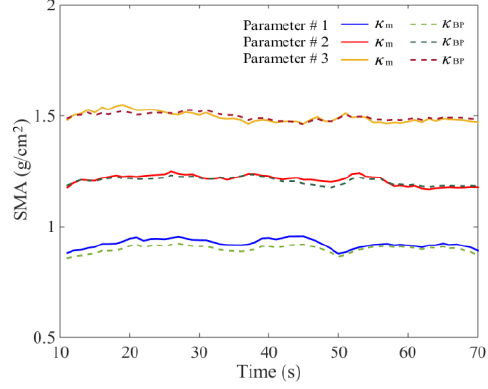
Figure 9. DEM simulation results of κ 0 using κ m and κ BP .